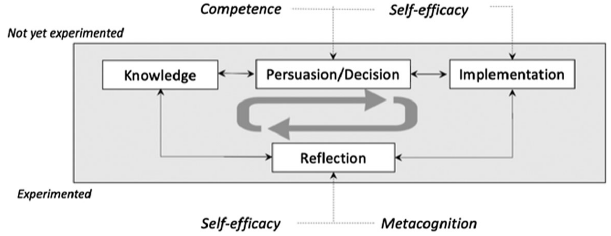
ments, reenvisioned to incorporate cyclic improvements and reflection (adapted from Andrews and Lemons [19], Fig. 3) and with some differentiation by experience with active learning (not yet experimented vs